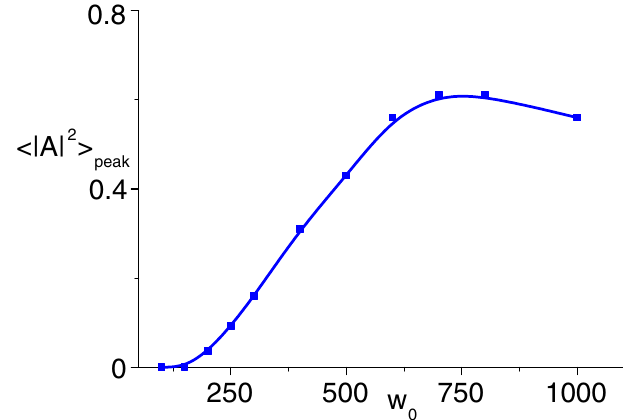
FIG. 8. (Color) hj A j 2 i laser profile for " 0 : 8